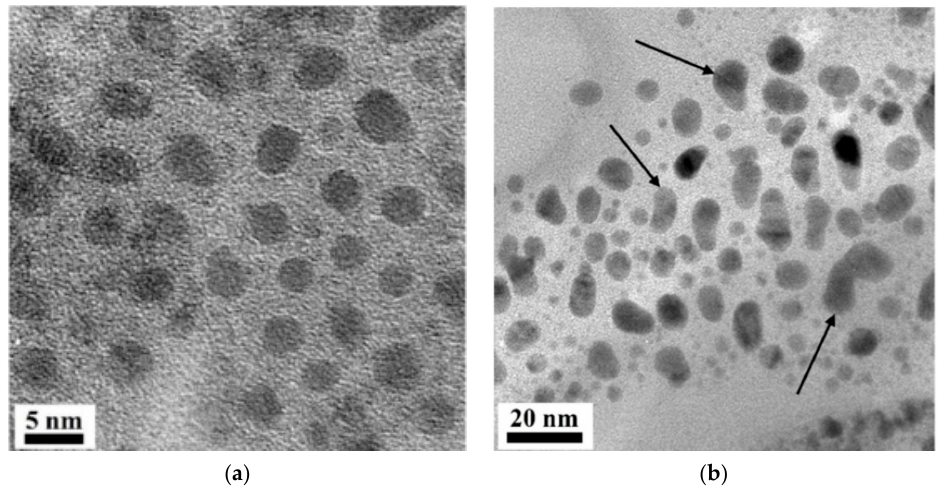
Figure 13. TEM micrographs of the Pt/AAO catalyst before CHC ( a ) and after 530 h CHC ( b ) (reproduced from [141]).